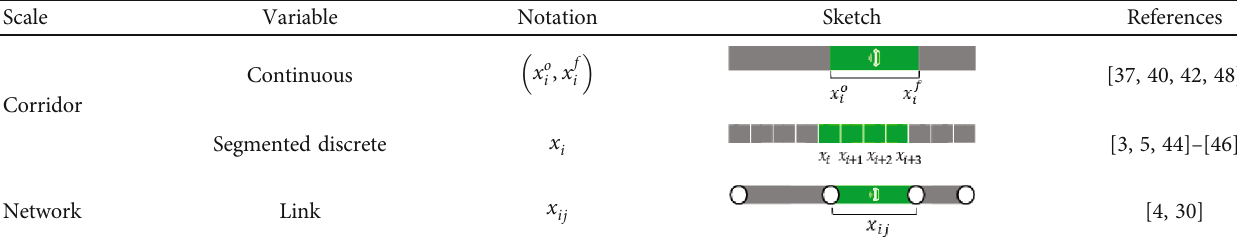
Table 1: Summary of recent studies in DWC facility deployment modeling